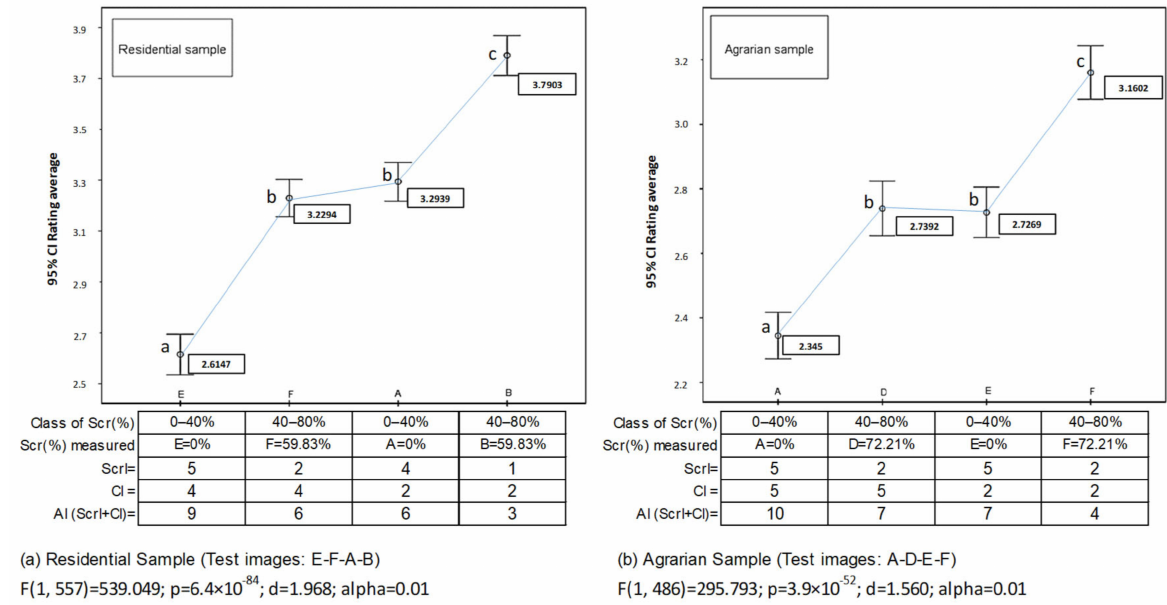
Figure 6. Results of repeated-measures ANOVA to quantify the combined effect of screening and building colour. ( a ) Rating average for Residential Sample (Test images: E-F-A-B, (Figure 4). ( b ) Rating average for Agrarian Sample (Test images: A-D-E-F, (Figure 4). Different letters in lower case indicate significant differences in RA between compared images (Bonferroni